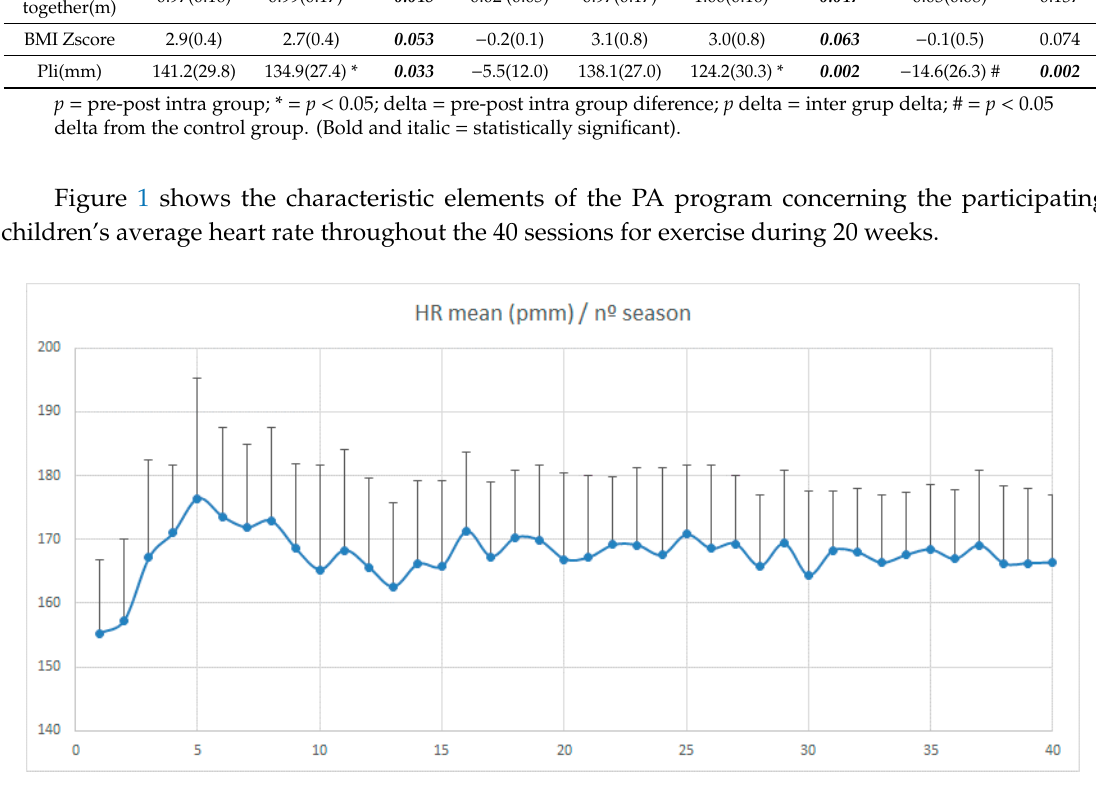
Table 4. Data from the questionnaire on attitude toward physical education in girls and boys (Mean and SD)—pre-intervention.